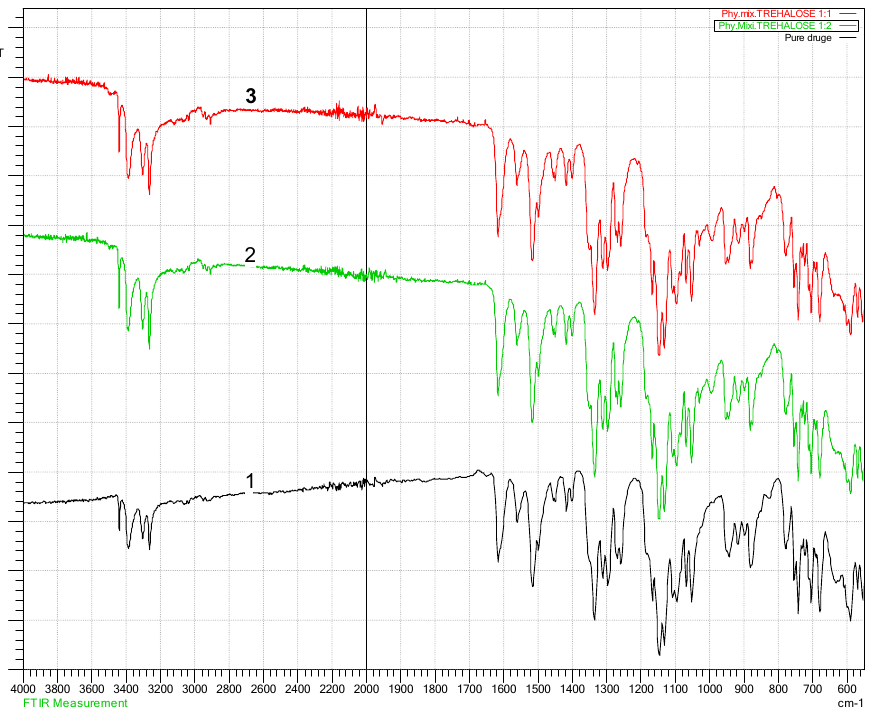
Figure 5. Drug-trehalose FT-IR showing no change on peak locations, but there is a significant change on peak intensities. 1 (black colour): Pure bendroflumethiazide; 2 (green colour): Drug: trehalose 1:2; 3 (red colour): Drug: trehalose 1:1.